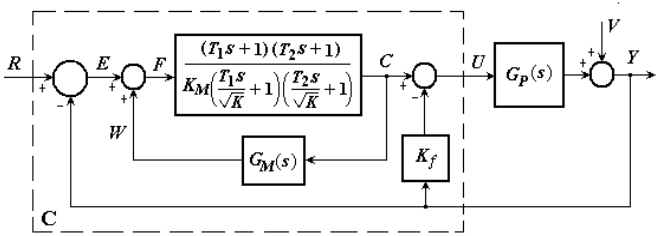
Figure 1. Closed-loop system with proportional-internal model control (P-IMC) controller, P 0 -IMC type.